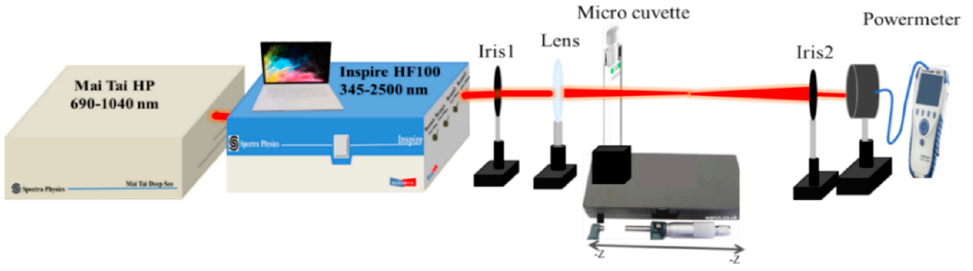
Figure 2. Schematic diagram of Z-scan setup.